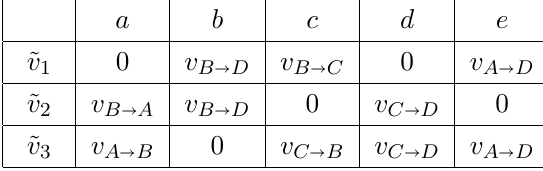
Table 2 . Explicit check that the ~ v ’s de(cid:12)ned by (2.6) are indeed (cid:13)ows, given the partition in table 1. i Each row gives an equation with l.h.s. being the (cid:12)rst column and r.h.s. the sum of the terms in the remaining columns, as in table 1. The columns correspond to the distinct bulk regions (cf. (cid:12)gure 2) and we see that in each region, ~ v is manifestly a i